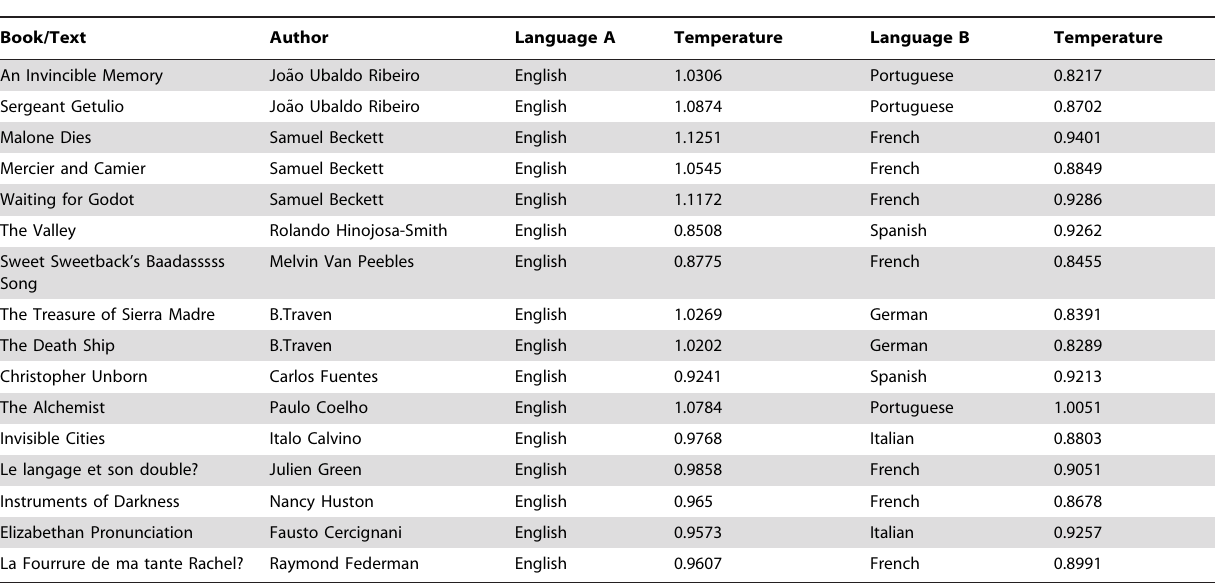
Comparative table of characteristic temperatures values for 16 books translated by the own authors. doi:10.1371/journal.pone.0110213.t003 PLOS ONE |